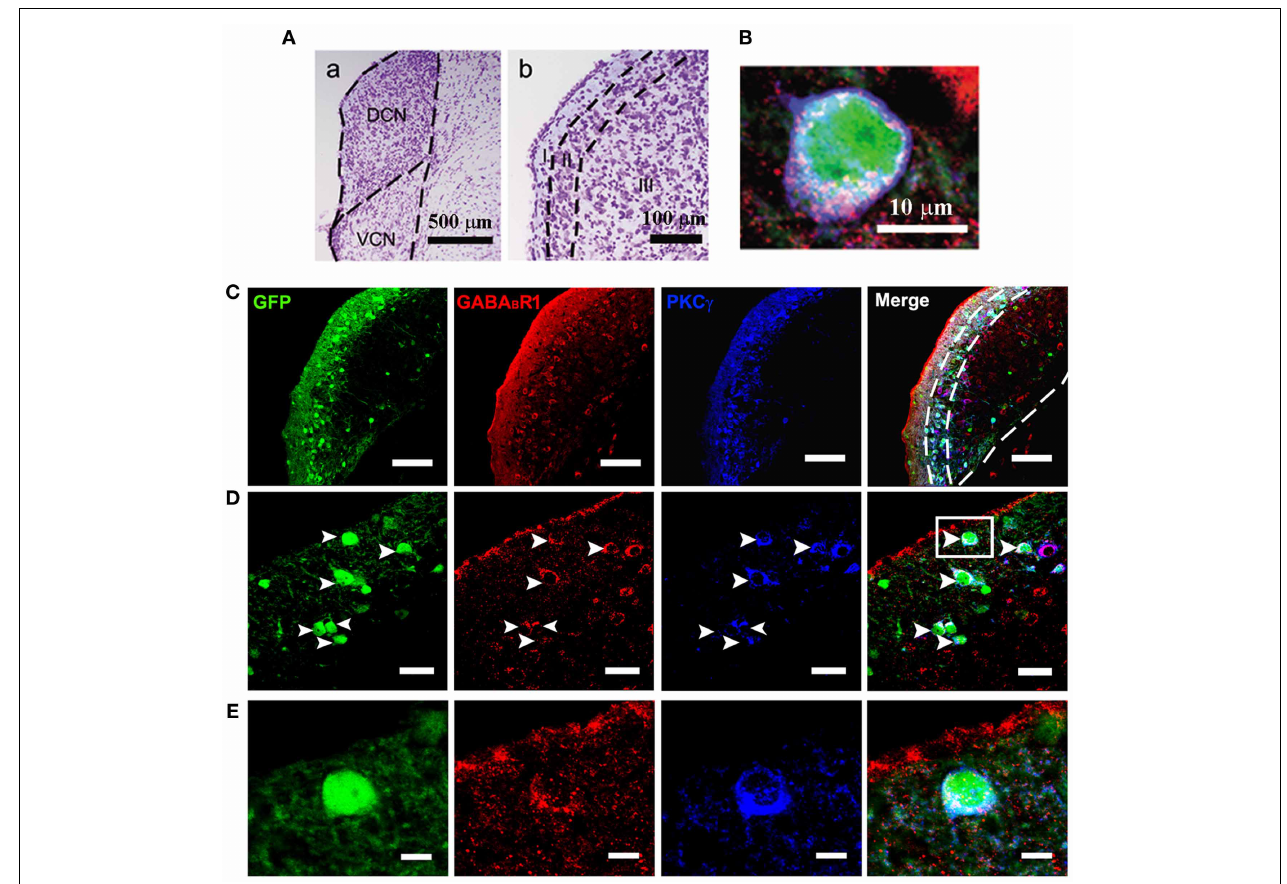
FIGURE 1 | Photomicrographs representing sections of the brainstem of GAD67-GFP knock-in mice in the DCN. Nissl staining in the CNC (A) showing the dorsal part (DCN) and the ventral part (VCN) (a in A ). The DCN organized into a layered structure (b in A ): the molecular layer (I), the fusiform cell layers (II) and the deep layer (III). Triple-labeled neurons for GFP/GABA B R1/PKC γ were shown (B) . Fluorescent photomicrographs showing the distribution of the GFP-labeled (green), GABA B R1-positive (red)